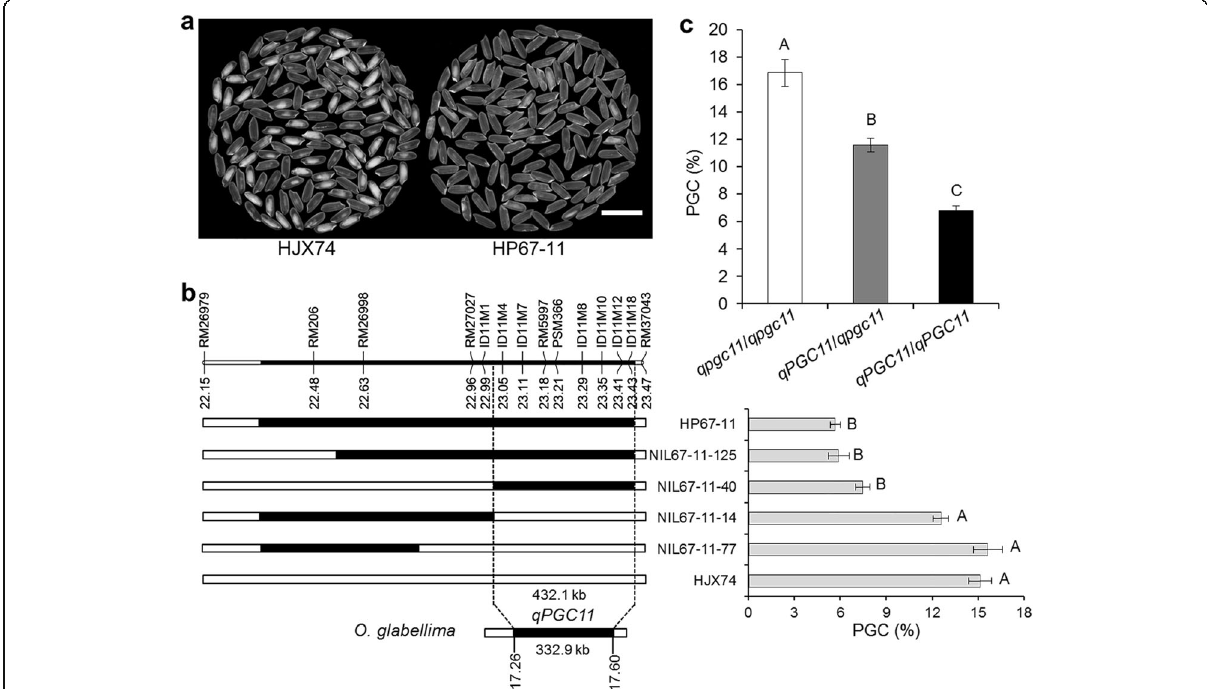
Fig. 3 Substituted mapping of qPGC11 for grain chalkiness. a , The head rice appearance of the HJX74 and HP67 – 11. Scale bar: 1 cm. b , Substitution mapping of qPGC11 . The positions of substitution segments and the PGC of HP67 – 11 and its NILs are shown, with HJX74 as the control. The numbers under the chromosome are physical distance (Mb). White and black blocks represent the homozygous genotypes of HJX74 and HP67 – 11, respectively. c , PGC effects of three genotypes of qPGC11 in an F 2 population. qpgc11 / qpgc11 represents homozygous genotype of HJX74 ( n = 26); qPGC11 / qpgc11 represents heterozygous genotype of HJX74/HP67 – 11 ( n = 49); qPGC11 / qPGC11 represents homozygous genotype of HP67 – 11 ( n = 30). Significance analysis in b and c was by one-way ANOVA, Duncan, two-tailed. Values in the lines among different letters